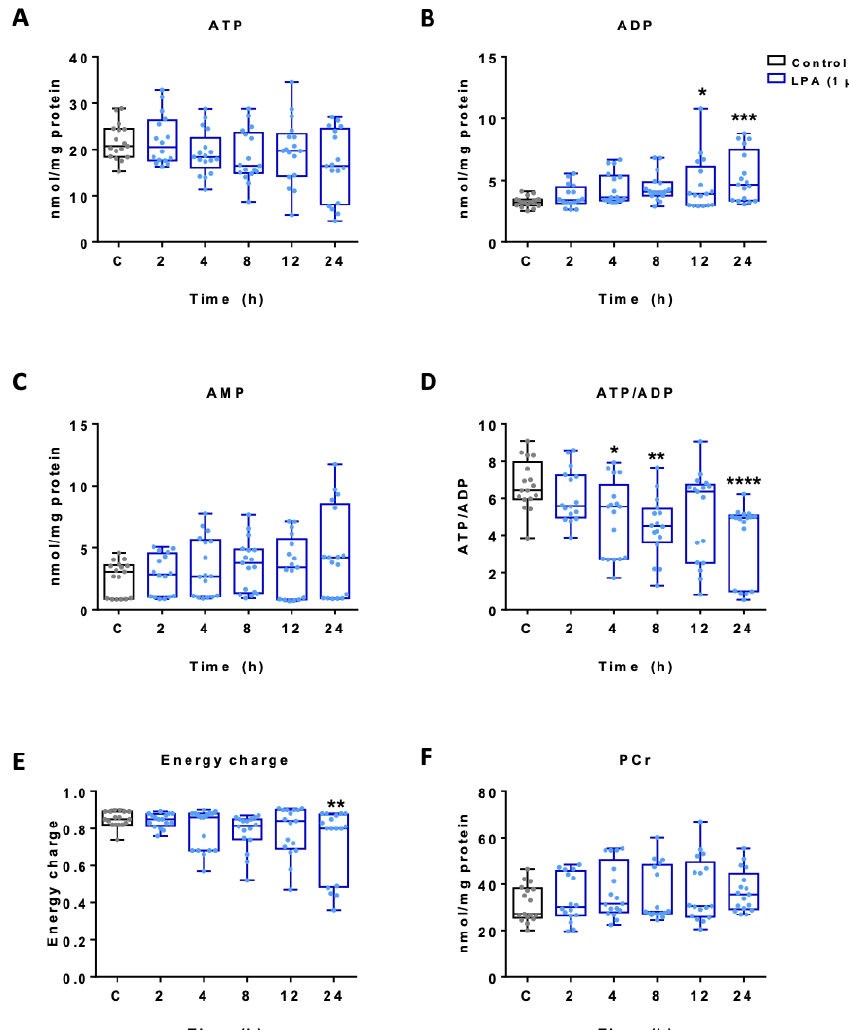
Figure 2. Effect of LPA on adenine nucleotide and phosphocreatine content in BV-2 microglia. Total cellular adenine nucleotide and phosphocreatine (PCr) content of BV-2 microglia incubated in the absence (c) and presence of 1 µ M LPA was quantified using HPLC. Graphs represent the concentration of ( A ) ATP, ( B ) ADP, ( C ) AMP, ( D ) ATP/ADP ratio, ( E ) the energy charge (EC) calculated as EC = ([ATP + 1/2ADP]/[ATP + ADP + AMP]) and ( F ) phosphocreatine concentration. Results are presented as mean values ± SEM of 3 independent experiments. (* p < 0.05, ** p < 0.01, *** p < 0.001, **** p < 0.0001 compared to control; one-way ANOVA with Bonferroni correction).